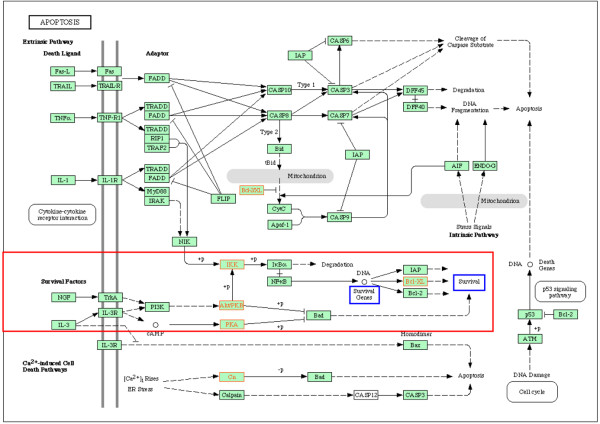
Inter-individual mRNA expression variances in the complex of apoptosis in rheumatoid arthritis (RA) compared with normal control (NC). The graph shows genes affected by significant intra-group inter-individual mRNA expression variances in RA compared with NC (P ≤ 0.05; Bonferroni/Holm corrected Brown-Forsythe version of the Levene test; labeled in red) in the Kyoto Encyclopedia of Genes and Genomes (KEGG) complex of apoptosis. Among the three apoptosis sub-complexes, the survival factor-dependent sub-complex was significantly affected by gene expression variances (P ≤ 0.15, χ2 test; indicated in red). Cellular processes with potential influence on or relevance for RA pathogenesis (expression of survival genes and cell survival) are labeled in blue.